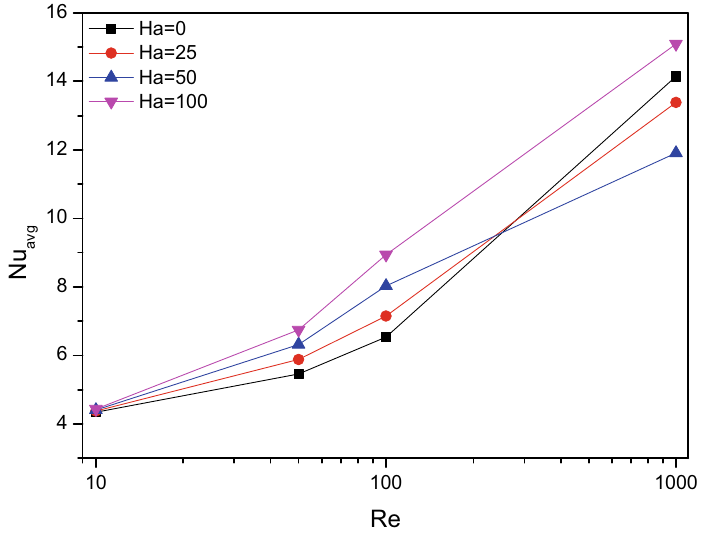
Figure 7. Variations of Nu avg with various Re for Ha variations, Re = 1000 , ϕ = 0.02